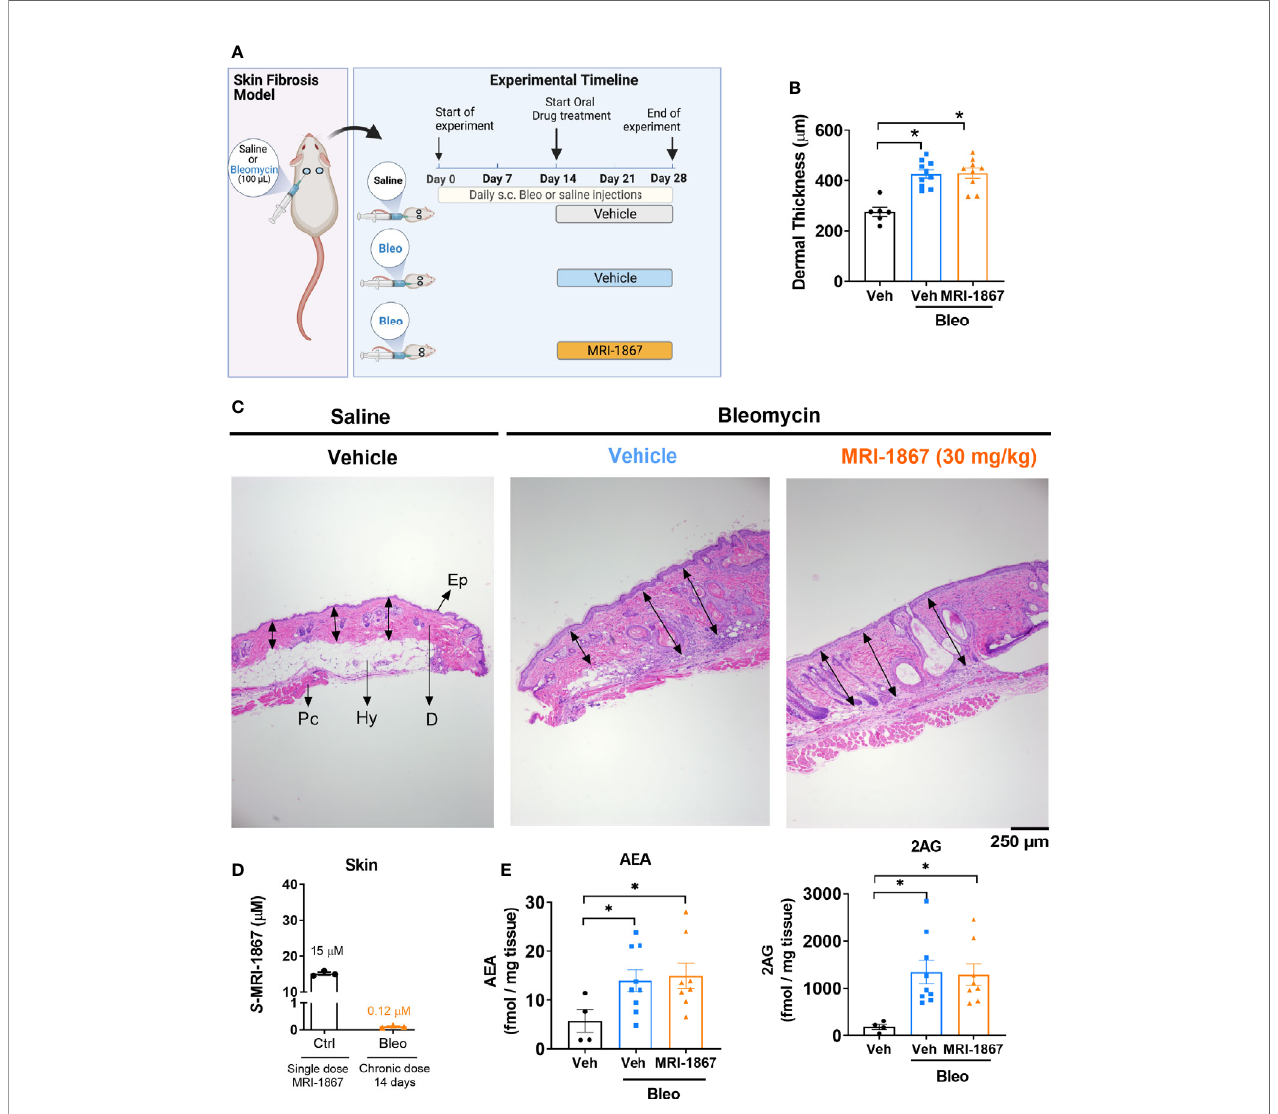
FIGURE 1 | Bleomycin-induced skin fi brosis minimizes skin exposure and target engagement by MRI-1867 in C57BL6/J mice. (A) Schematic presentation of bleomycin-induced skin fi brosis development and therapeutic treatment regime. (B) Dermal thickness quanti fi cation for histological images. (C) Representative histological images from skin biopsies stained with H&E Ep, Epidermis; D, Dermis; Hy, Hypodermis and adipose tissue; Pc, Panninculus carnosus. Double arrow indicates dermal length that used for quanti fi cation. (D) Levels of MRI-1867 in control and bleomycin-treated skin biopsy specimens following acute or 14-day chronic administration of MRI-1867 at 10 mg/kg, respectively. (E) Levels of endocannabinoids AEA and 2AG in skin biopsies. Data represent means ± SEM from 3-10 mice per group. Data were analyzed by 1-way ANOVA followed by Dunnett ’ s multiple comparisons test. Signi fi cant difference from corresponding values in controls (saline and vehicle treated group) (*P <